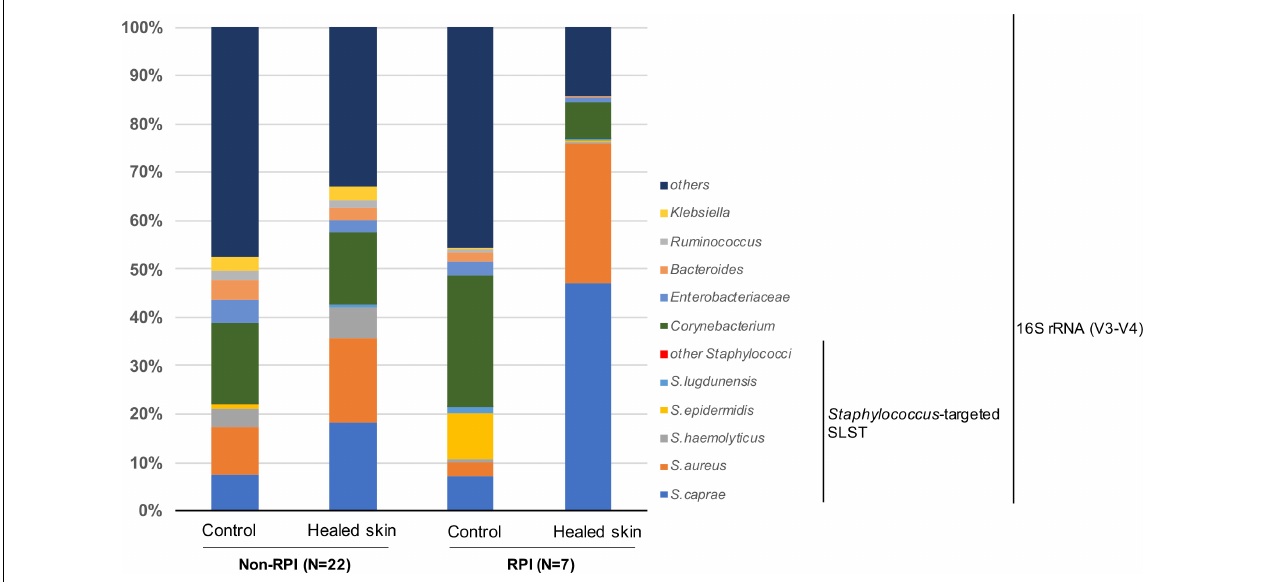
FIGURE 1 | Composition of Staphylococcus spp. and the top five skin bacteria on the skin sites. Average abundance was shown for the control site of non-RPI patients ( n = 22), healed skin sites of non-RPI patients ( n = 22), control sites of RPI patients ( n = 7), and healed skin sites of RPI patients ( n = 7). The full sets of staphylococci are shown in Supplementary Figure 2 . The composition of each sample is shown in Supplementary Figure 3 .